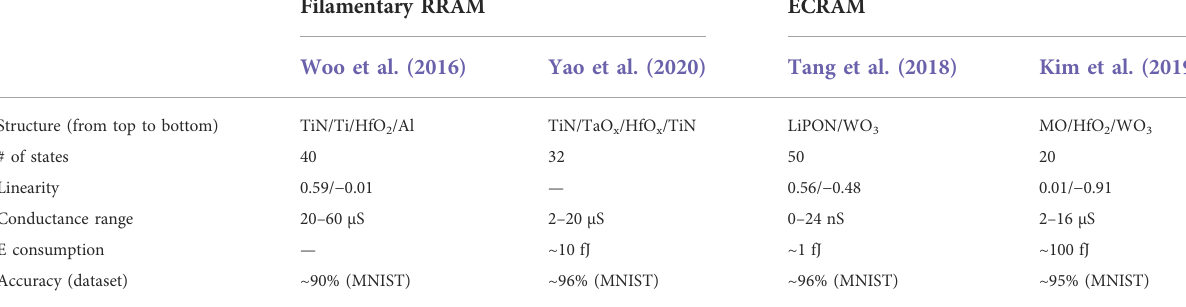
TABLE 1 Benchmark table showing synaptic update metrics for fi lamentary RRAM and ECRAM